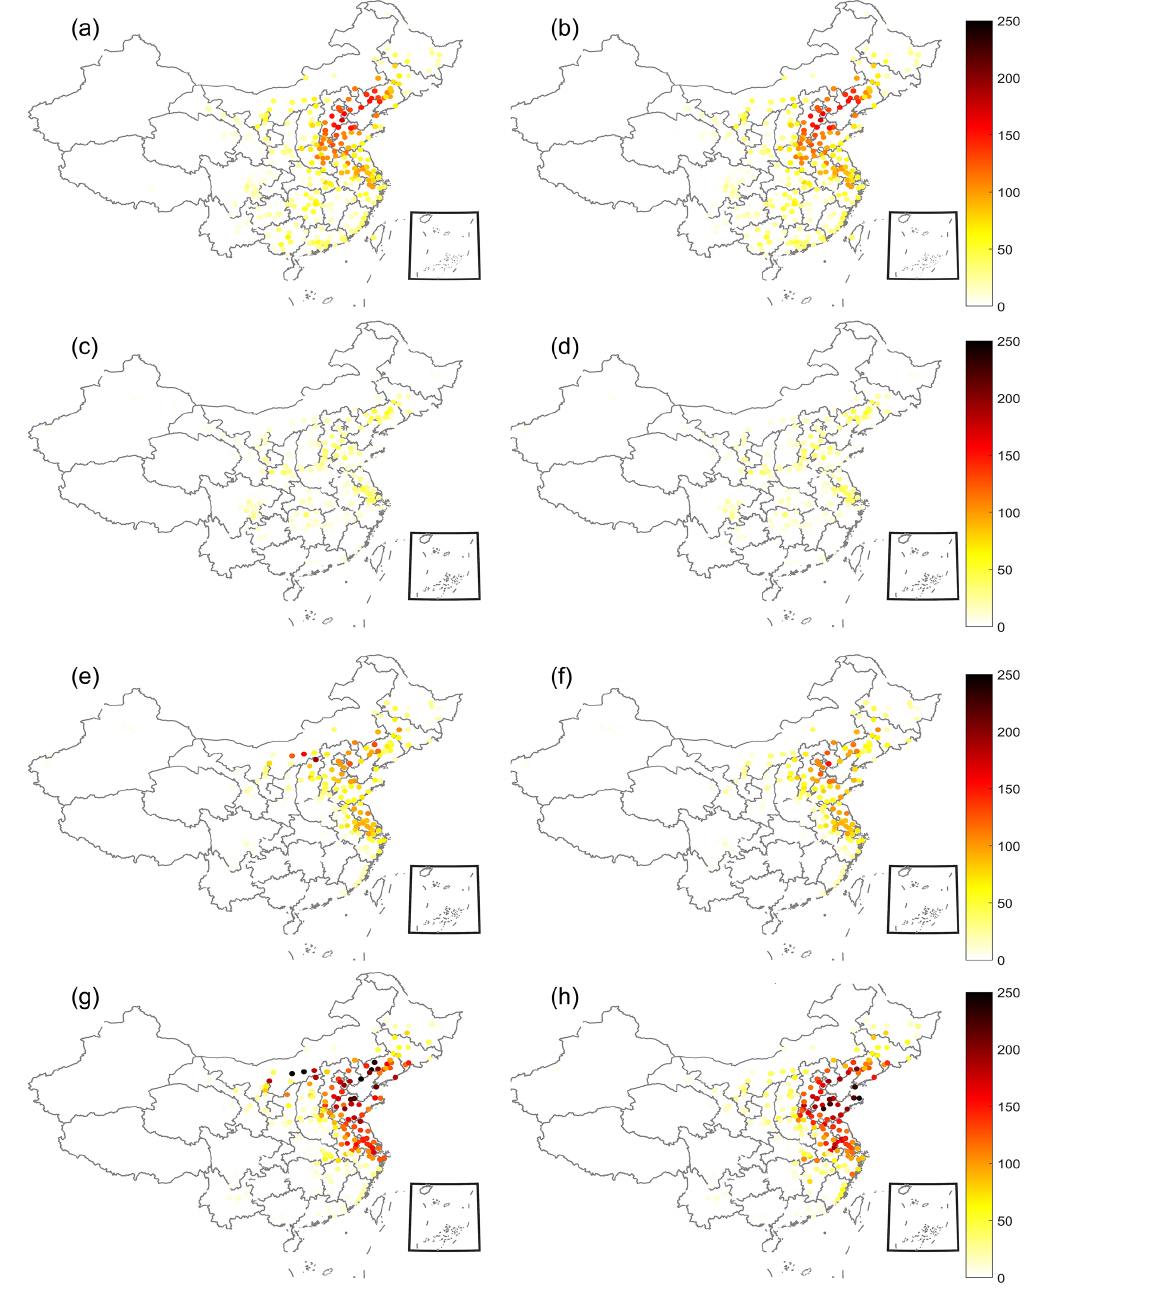
Figure 6. Distribution of in-weighted degree (a) and out-weighted degree (b) in the network of each node for seasonal data.